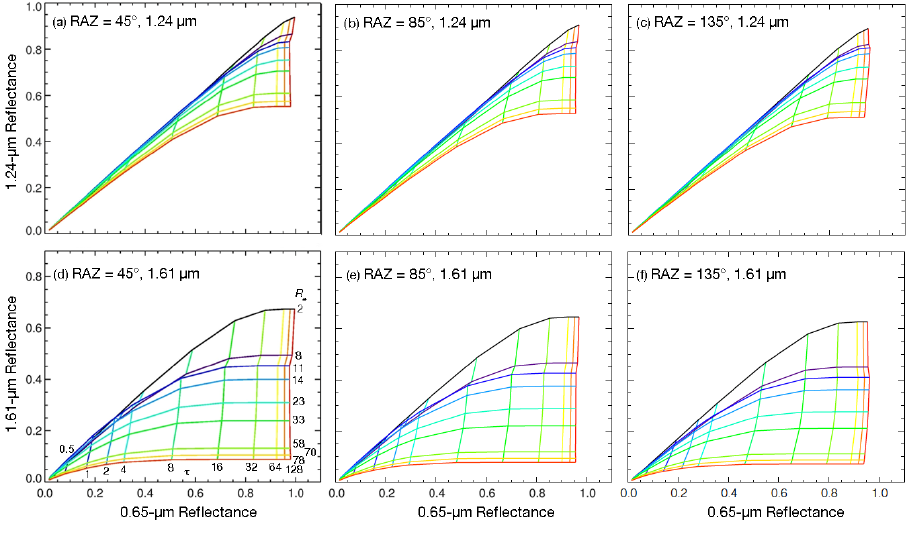
Figure 20. Same as Figure 19, except for the ice clouds.